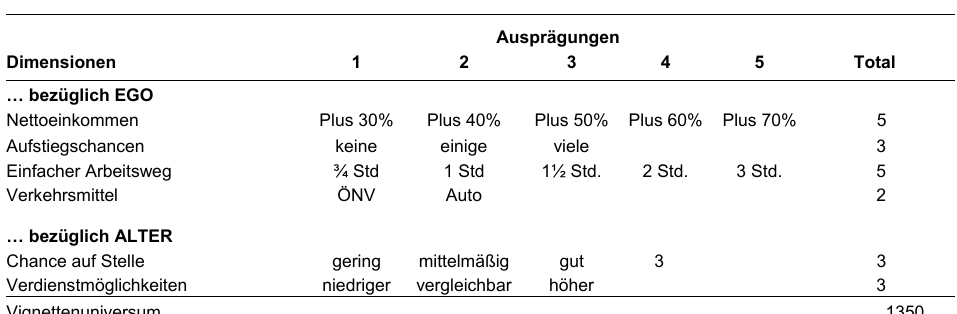
Tabelle 1: Vignettendimensionen und ihre